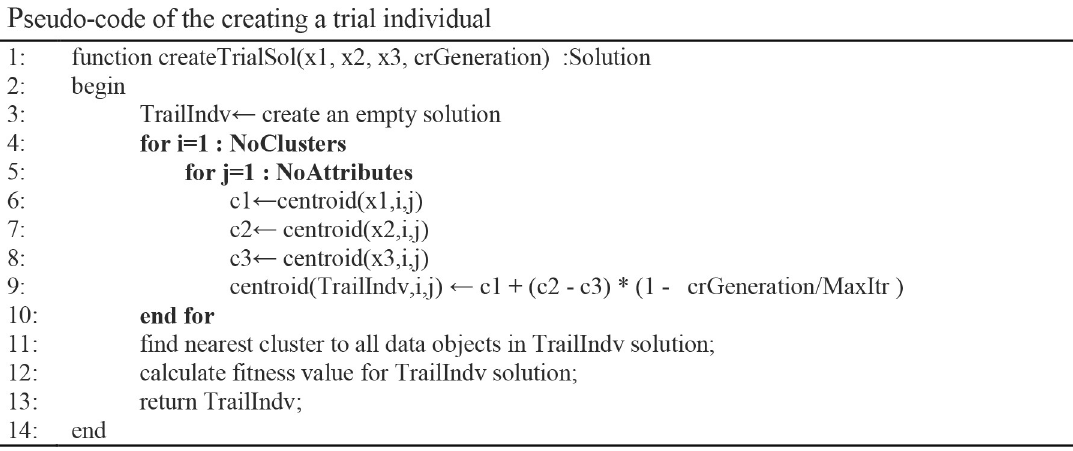
Fig 6. Pseudo-code of creating the trial individual algorithm.